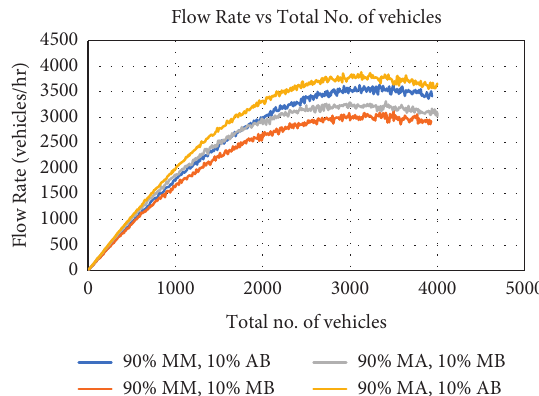
Figure 39: Speed vs. density fundamental diagrams for different compositions of MA, MM, AB, and MB.